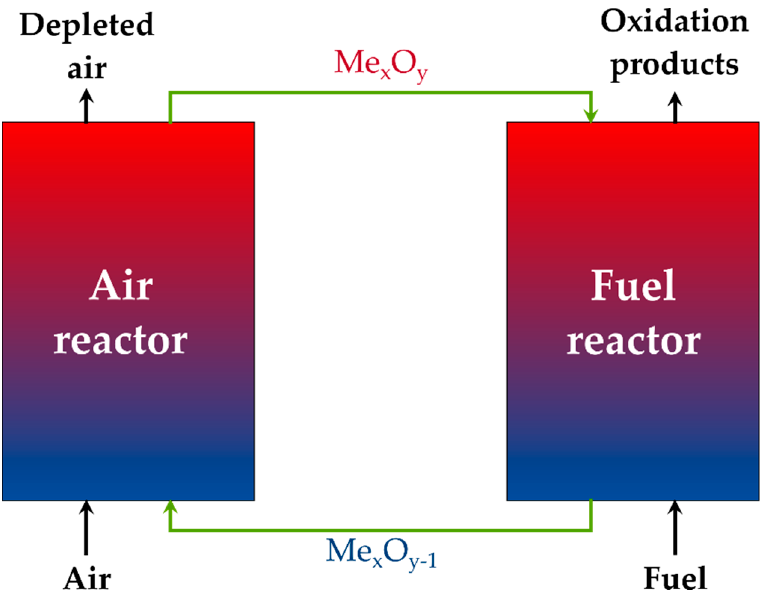
Figure 2. General flowsheet of the chemical looping process. 171